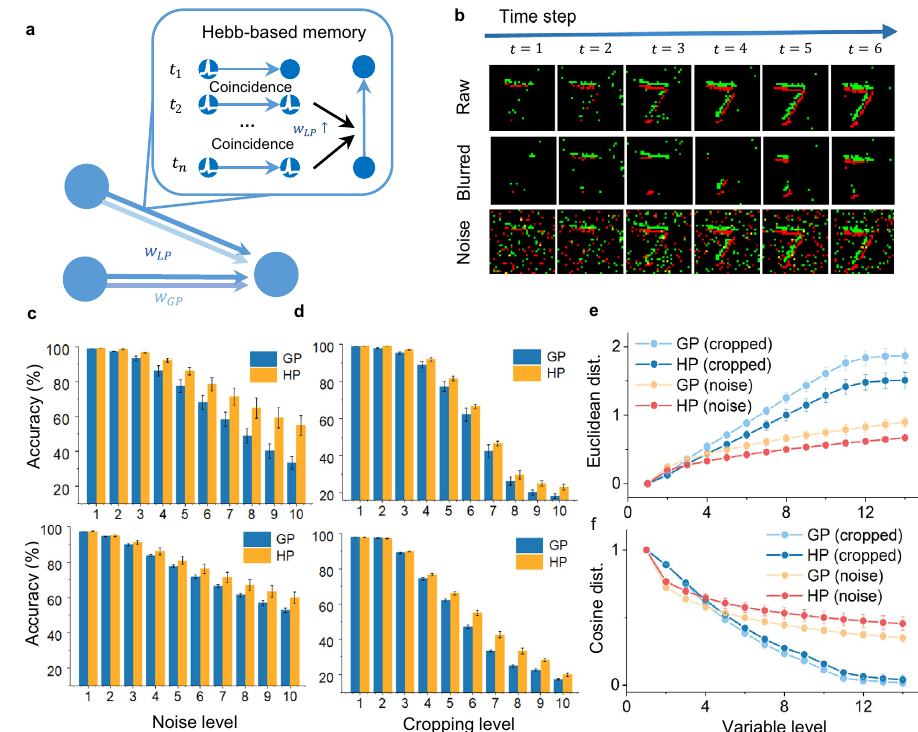
Fig. 4 Hybrid plasticity improves fault tolerance. a An illustration of the memory function provided by the correlation-based local module. When detecting a strong correlation between presynaptic and postsynaptic neurons, local weight w LP consolidates these synaptic weights with a learnable writing and decaying mechanism, which can help memorize repeated patterns and facilitate the recognition of similar stimulus. b Generation of incomplete data by cropping (the second row) and noise mixing (the third row) using N-MNIST data. We randomly cropped raw data (the fi rst row) with different cropping sizes or added different levels of salt-and-pepper noise. c Performance comparison in the cropping experiments using the N-MNIST (upper) and MNIST (lower). d Performance comparison in the noise experiments using the N-MNIST (upper) and MNIST (lower). e Euclidean distance between the hidden activation (membrane potential in the last timestep) of cropped MNIST data and those of the original MNIST data. f Cosine distance between the hidden activation of cropped MNIST data and original MNIST data. We plotted the average and standard deviations of ten repeated trials in c – f with * P <